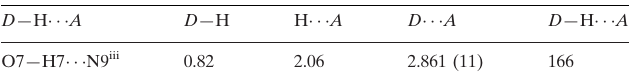
Hydrogen-bond geometry (A˚ , (cid:3)